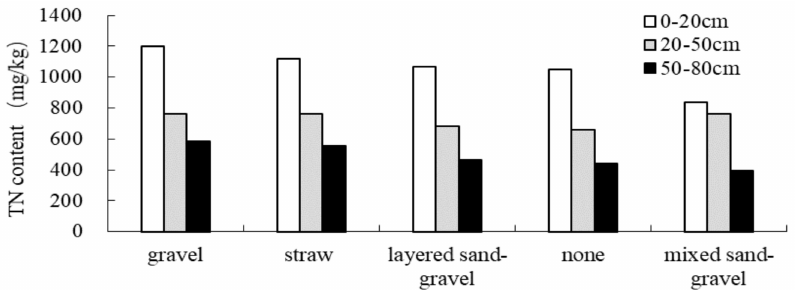
Figure 3. Total nitrogen (TN) content of the soil before drainage.